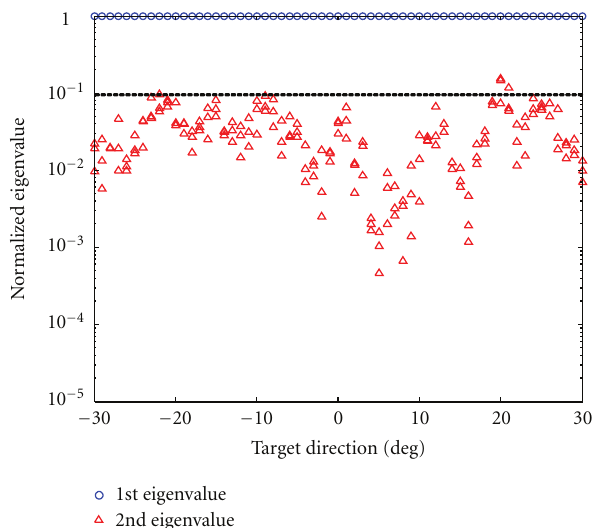
Figure 6: Normalized eigenvalue distribution derived from the measurements in anechoic chamber experiments.